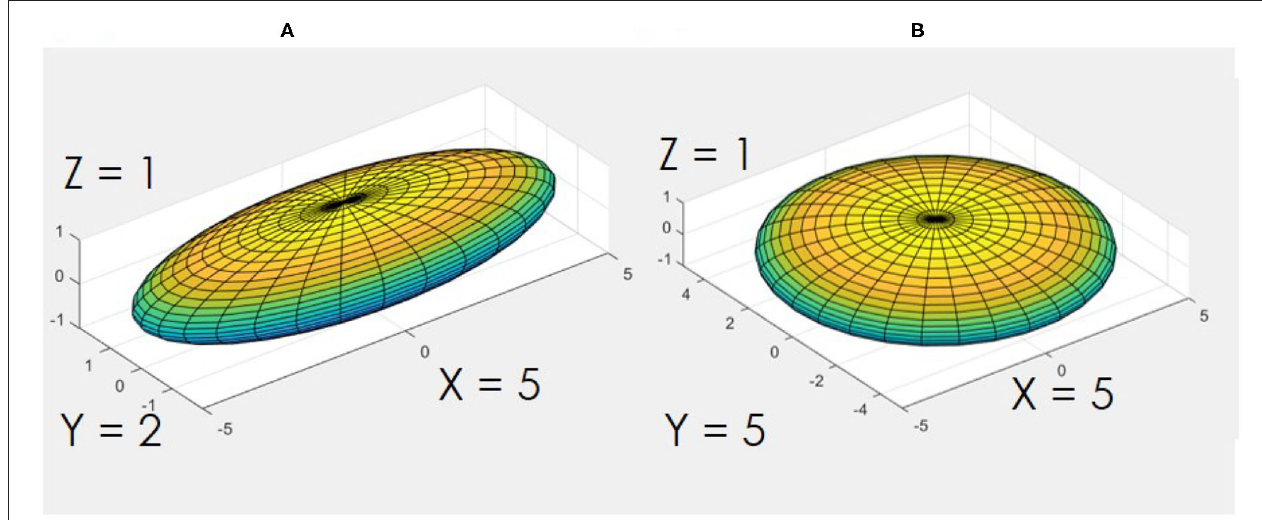
FIGURE 5 | Ellipsoid examples representing fractures of (A) 5:2:1 and (B) 5:5:1 aspect